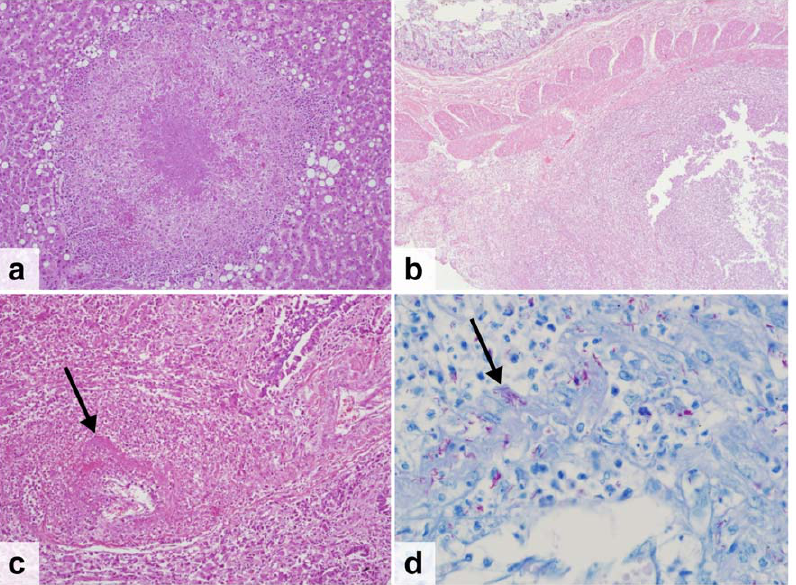
Figure 2. Spectrum of host response to mycobacterial infection in HIV-infected patients. a. Miliary nodule in the liver with a small granuloma in a patient with disseminated disease (H&E stain) b. Abscess in the submucosal lymph nodes of the small bowel (H&E stain) c–d. TB vasculitis in a lung vessel. The arrow indicates acid-fast bacilli in the pulmonary blood vessels (H&E stain, 20 6 and ZN stain, 100 6 ).